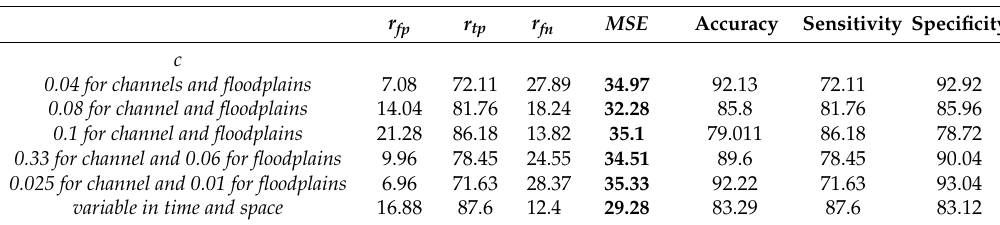
Table 3. Results of the hydraulic simulation model calibration performance for 4 November 2010 in terms of the flood extent map: the set of Manning coefficients c , false positive rate r fp , true positive rate r tp , false negative rate r fn , minimized sum of errors ( MSE ), and accuracy, sensitivity, and